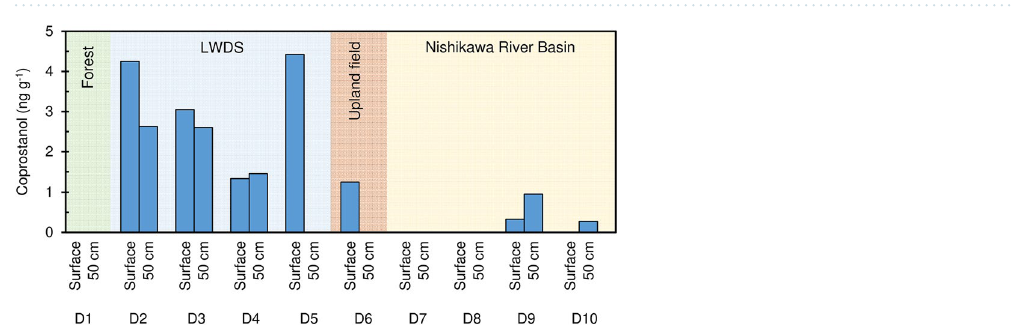
Figure 7. Temporal variation of nitrate in soil.